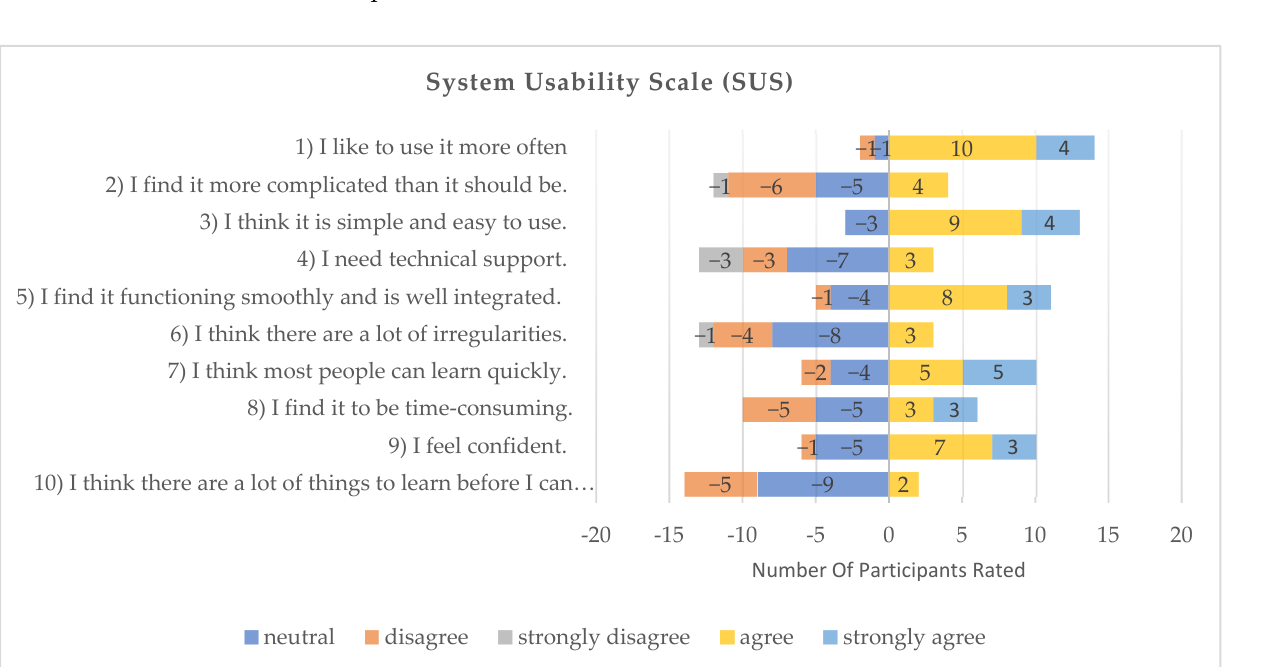
Figure 9. The system usability score (SUS) of the current virtual conference application.